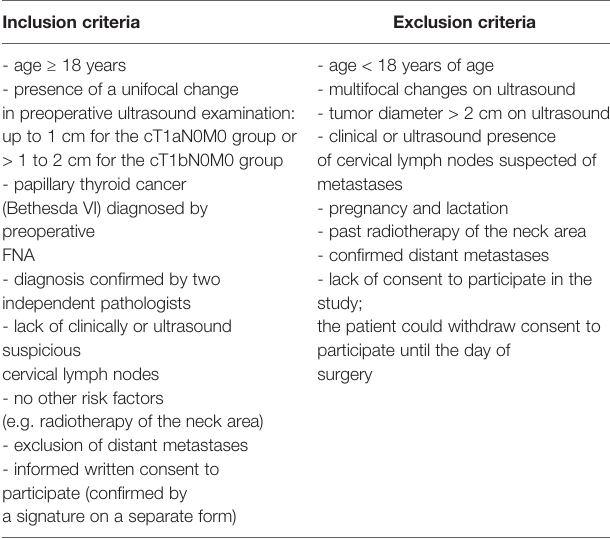
TABLE 1 | The inclusion and exclusion criteria from our prospective